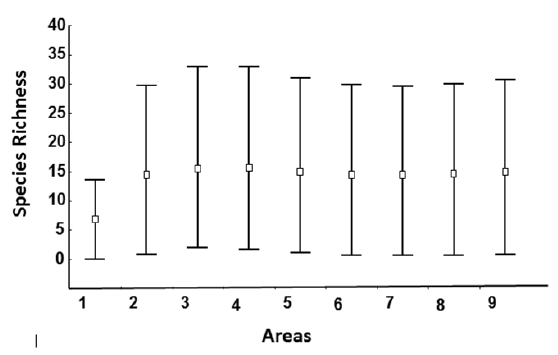
Fig. 2 - Rarefaction curve showing the species richness estimate by Jackknife index in nine restinga ecosystems studied on the coast of the State of Bahia,